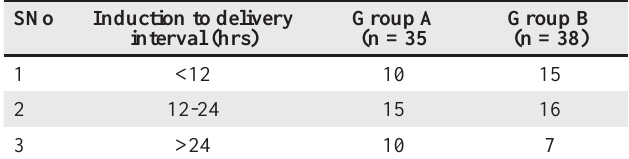
Table 1 : Induction to delivery interval